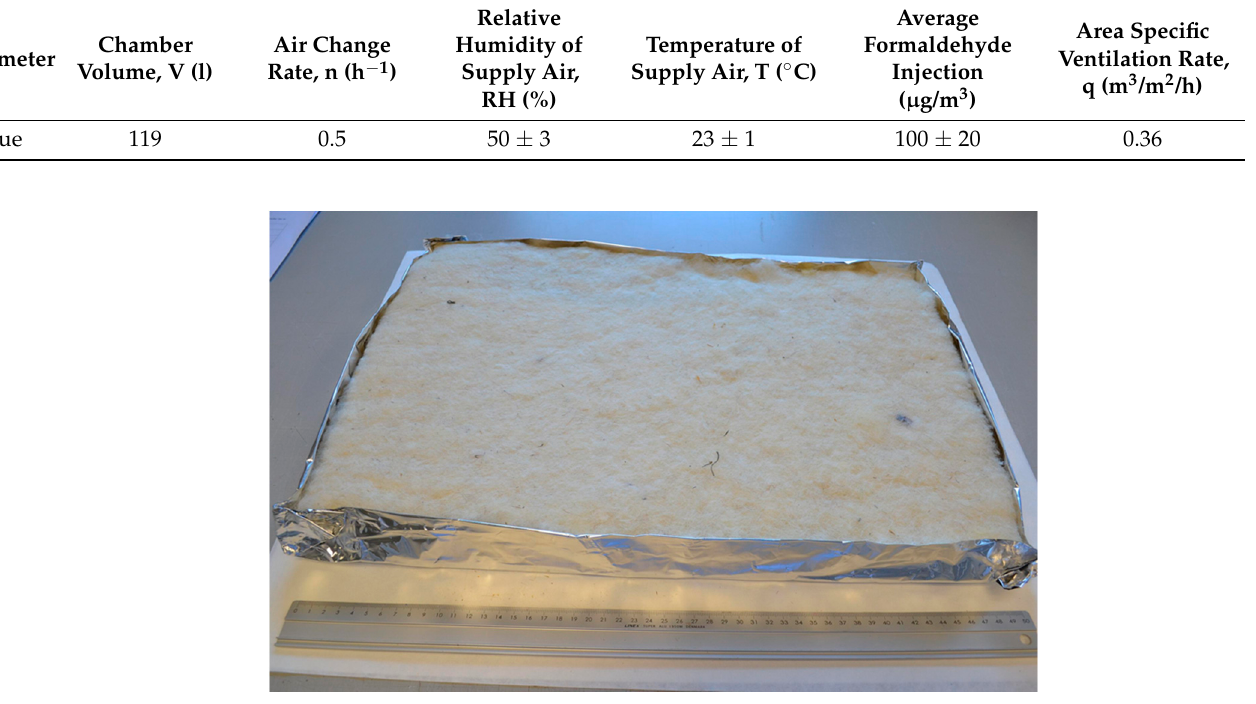
Figure 3. Sheep wool mattress sample. Table 3. Formaldehyde absorption test parameters.